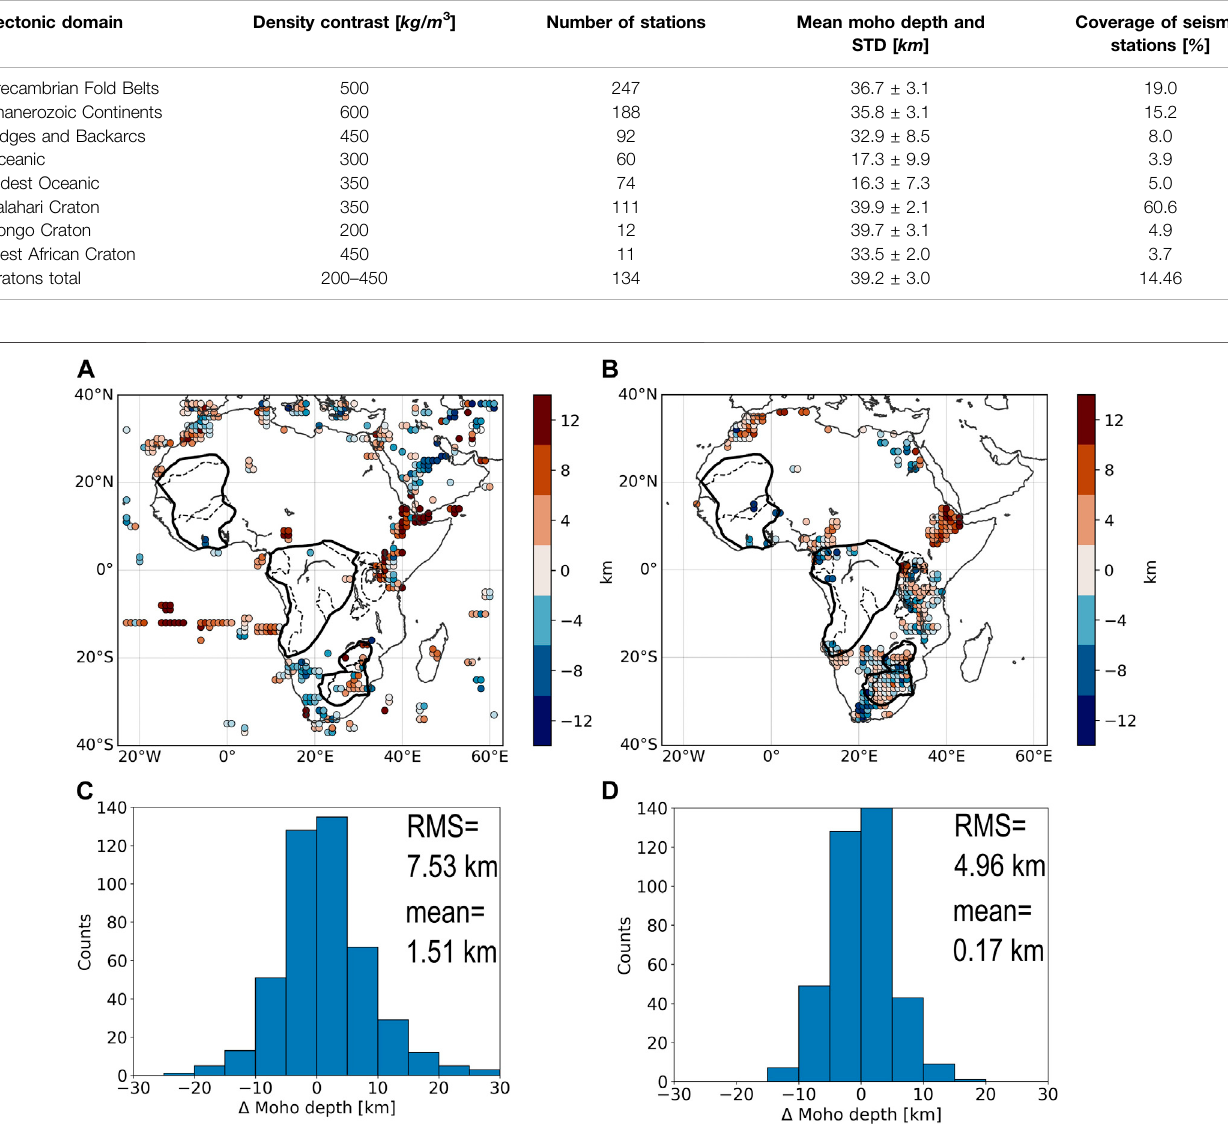
Frontiers in Earth Science |